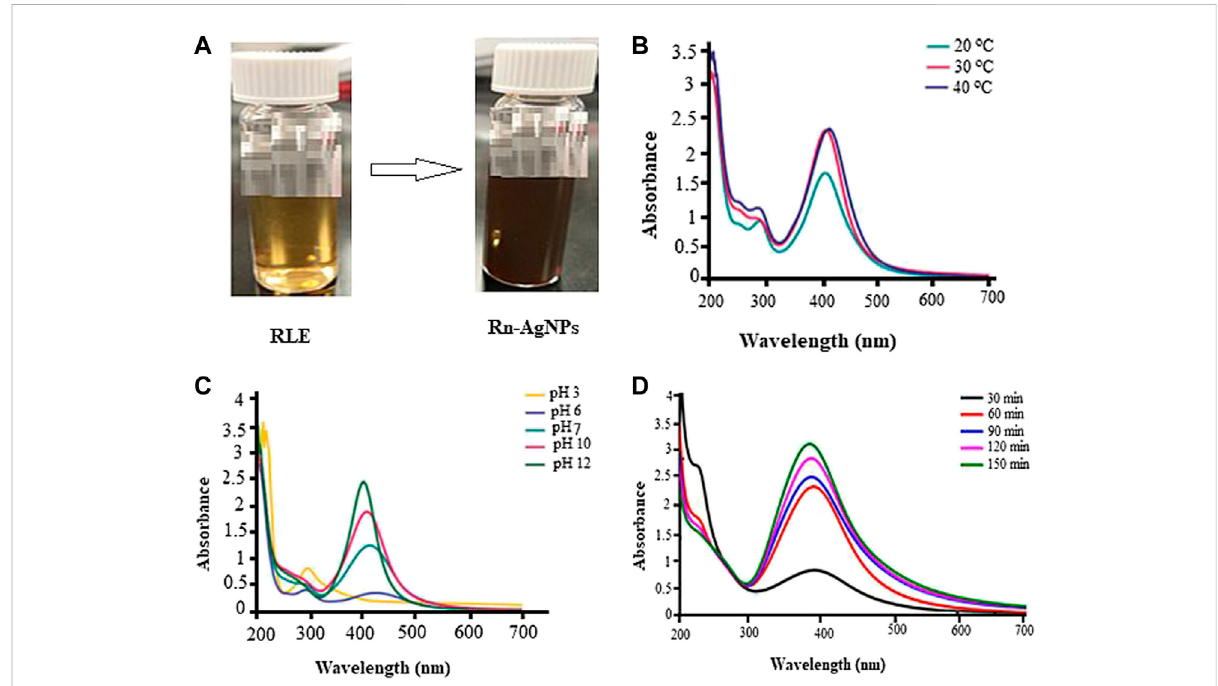
FIGURE 1 Biosynthesis and UV-Vis absorbance spectra of Rn-AgNPs under different reaction conditions) (A) coloration images, (B) pH, (C) temperature and (D) reaction time in colloidal